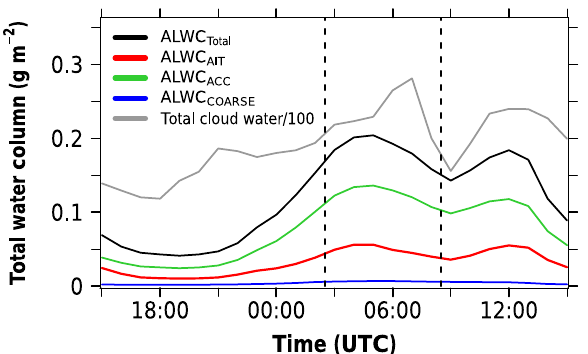
Figure 7. Diurnal cycle of the total cloud water column (gm − 2 ) as a median over the Ivory Coast (7.5–3 ◦ W, 4–10 ◦ N) from 2 July 15:00UTC to 3 July 15:00UTC with respect to ALWC Total (black), ALWC AIT (red), ALWC ACC (green) and ALWC COARSE (blue) as well as the median total cloud water (gray, divided by 100). Values below 10 − 3 gm − 2 are not considered. The vertical dashed lines de- note the three phases introduced in Fig.